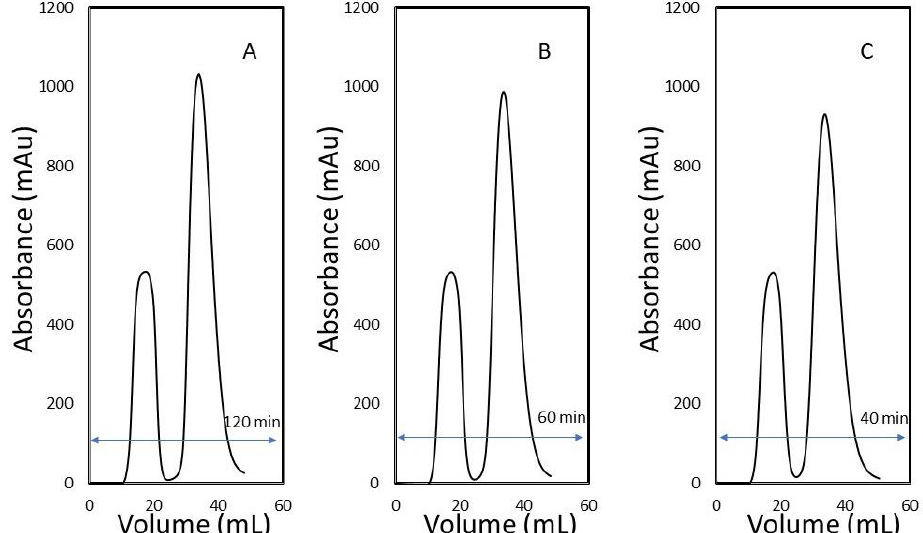
Table 3. Resolution in BSA – lysozyme separation using Sephacryl S-200 HR medium packed 24 mL Tricorn GL 10/300 column and 24 mL z 2 cuboid SEC device (mobile phase: phosphate-buffered sa- line, pH 7.4; loop: 5 mL; feed: 5 mg/mL BSA + 2.5 mg/mL lysozyme).